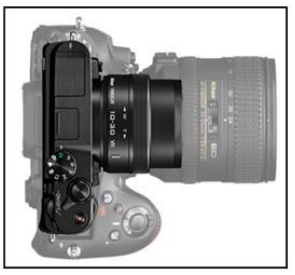
Figure 2. © Comparison of mirrored and mirrorless cameras in terms of dimensions (Url-3,2017)